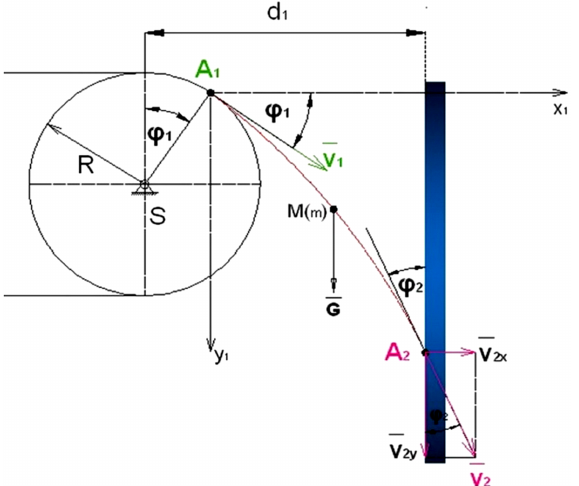
Figure 3. Movement of material particle from point A1 to point of impact A2.